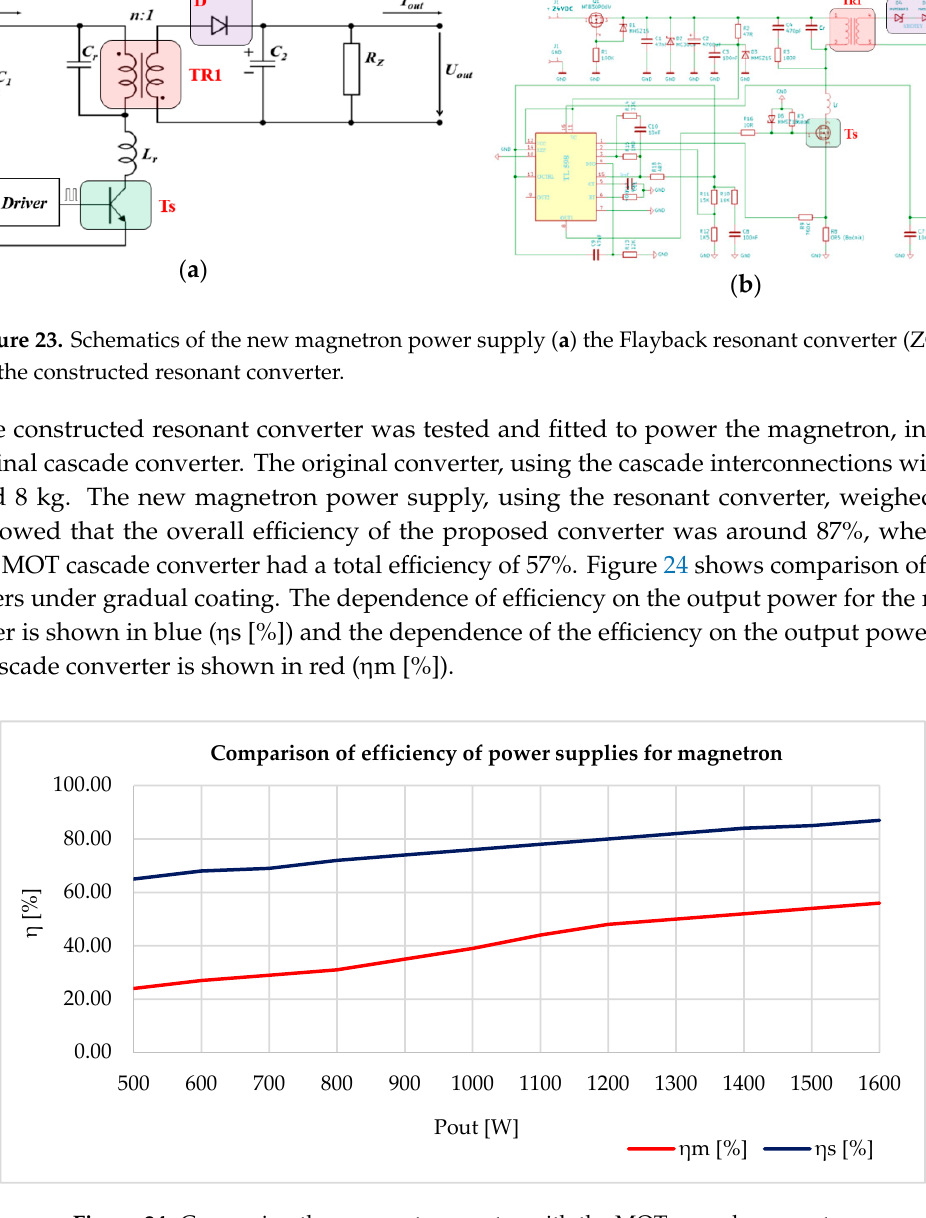
Figure 24. Comparing the resonant converter with the MOT cascade converter.